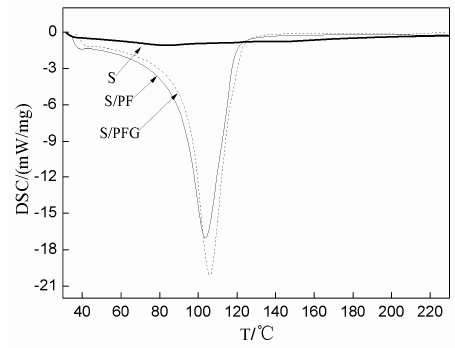
Figure 3. Differential Scanning Calorimetry spectra of soy-based adhesive (S) with or without cross-linker PF or PFG.